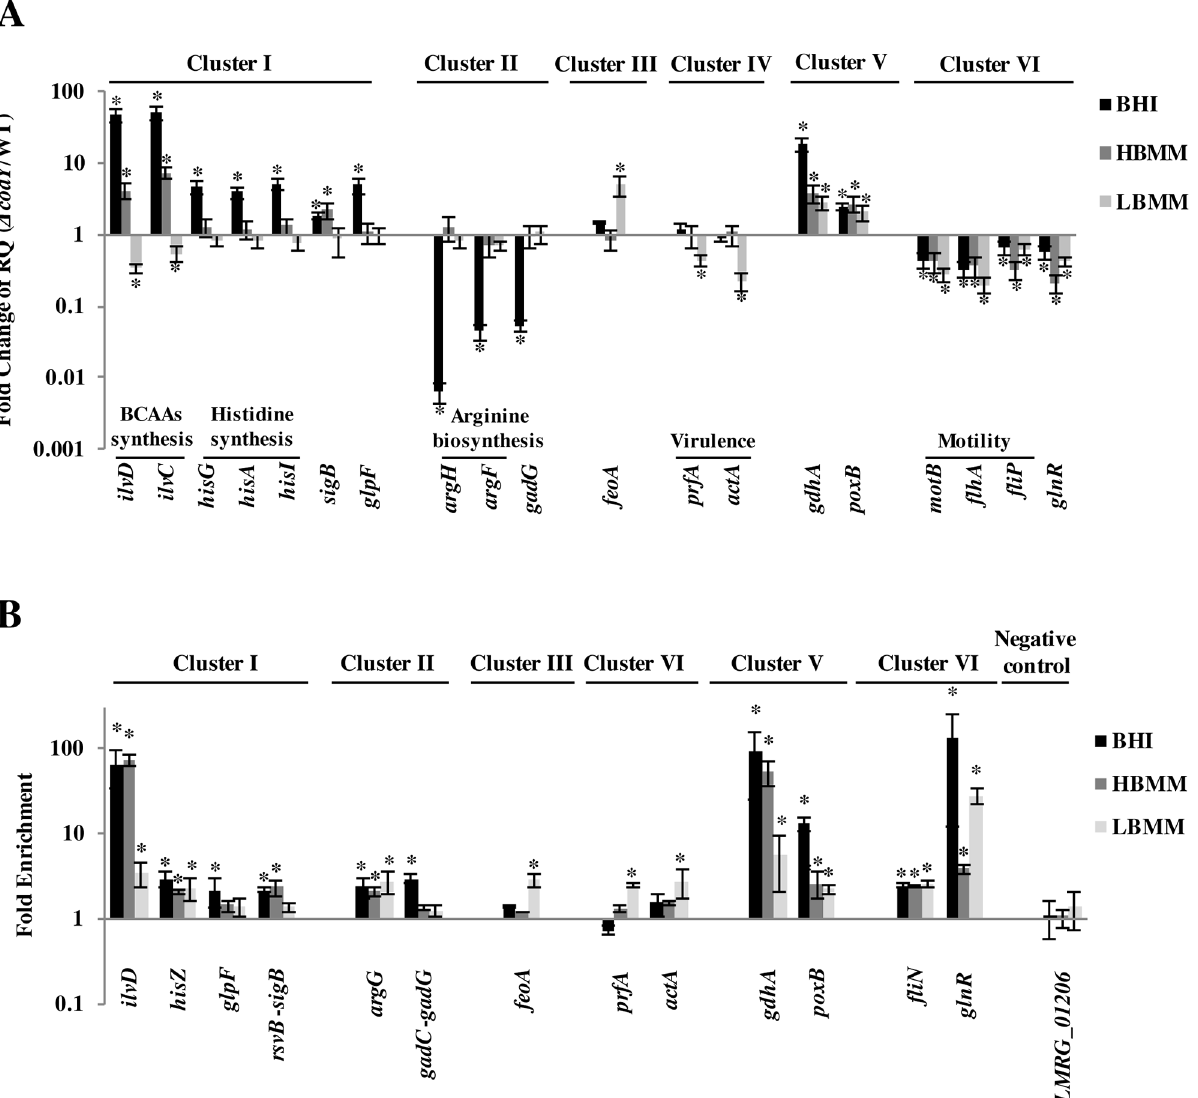
Fig 4. Validation of CodY-dependent differential transcription and CodY binding to representative genes from each cluster using RT-PCR and ChIP RT-PCR. A. RT-PCR transcription analysis of representative genes of each cluster presented by fold change values of mRNA relative quantity (RQ) in WT vs . Δ codY bacteria grown in BHI, HBMM and LBMM media. Results are average of at least 3 independent biological repeats. Transcription levels were normalized to the transcription of rpoD . Error bars represent standard error (SE). B. ChIP RT-PCR analysis of CodY binding to representative genes from each cluster (corresponding panel A) in bacteria grown in BHI, HBMM and LBMM media. Fold enrichment of CodY association with each one of the tested sequences was first normalized to two control sequences: bglA and rpoD (normalization to multiple control genes was done by StepOne software of Applied biosystems) and then to its no-ChIP control. Results are average of at least 3 independent biological repeats. Error bars represent standard error (SE). Asterisk ( * ) represents p-value <